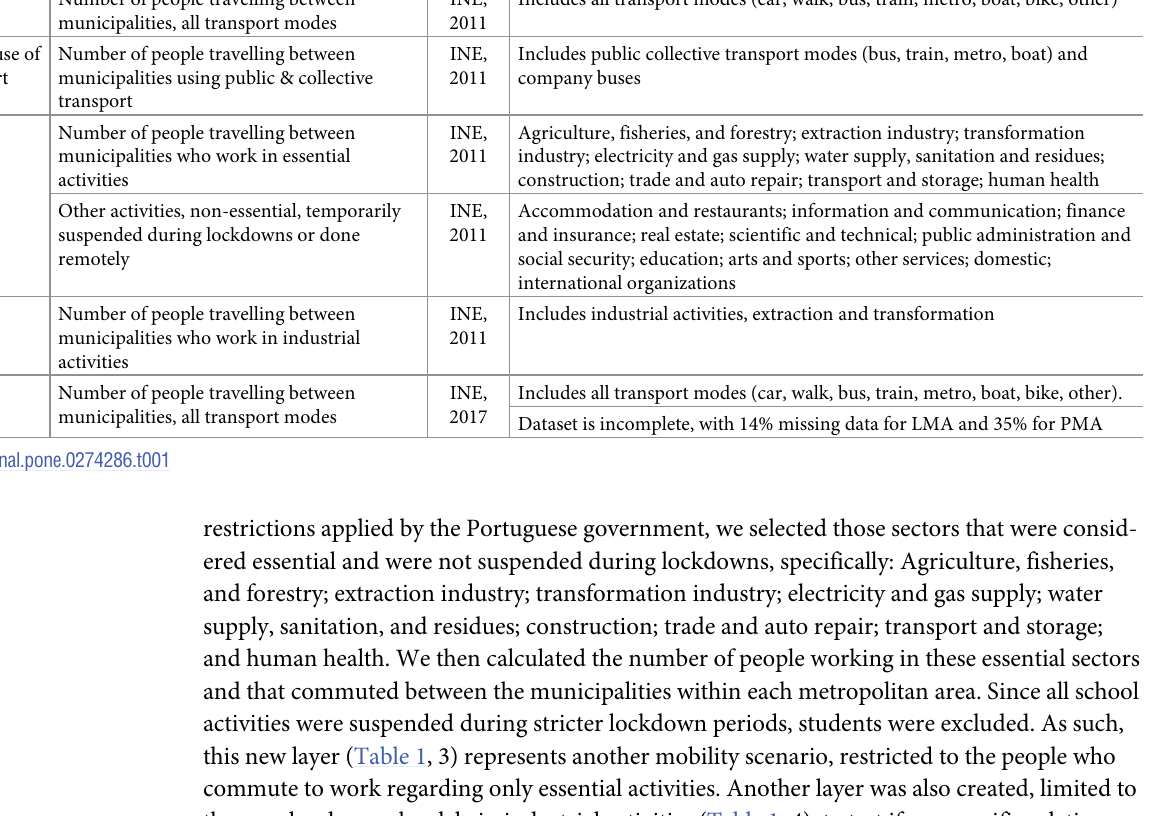
Table 1. Data collected regarding different mobility scenarios, for LMA and PMA. Mobility